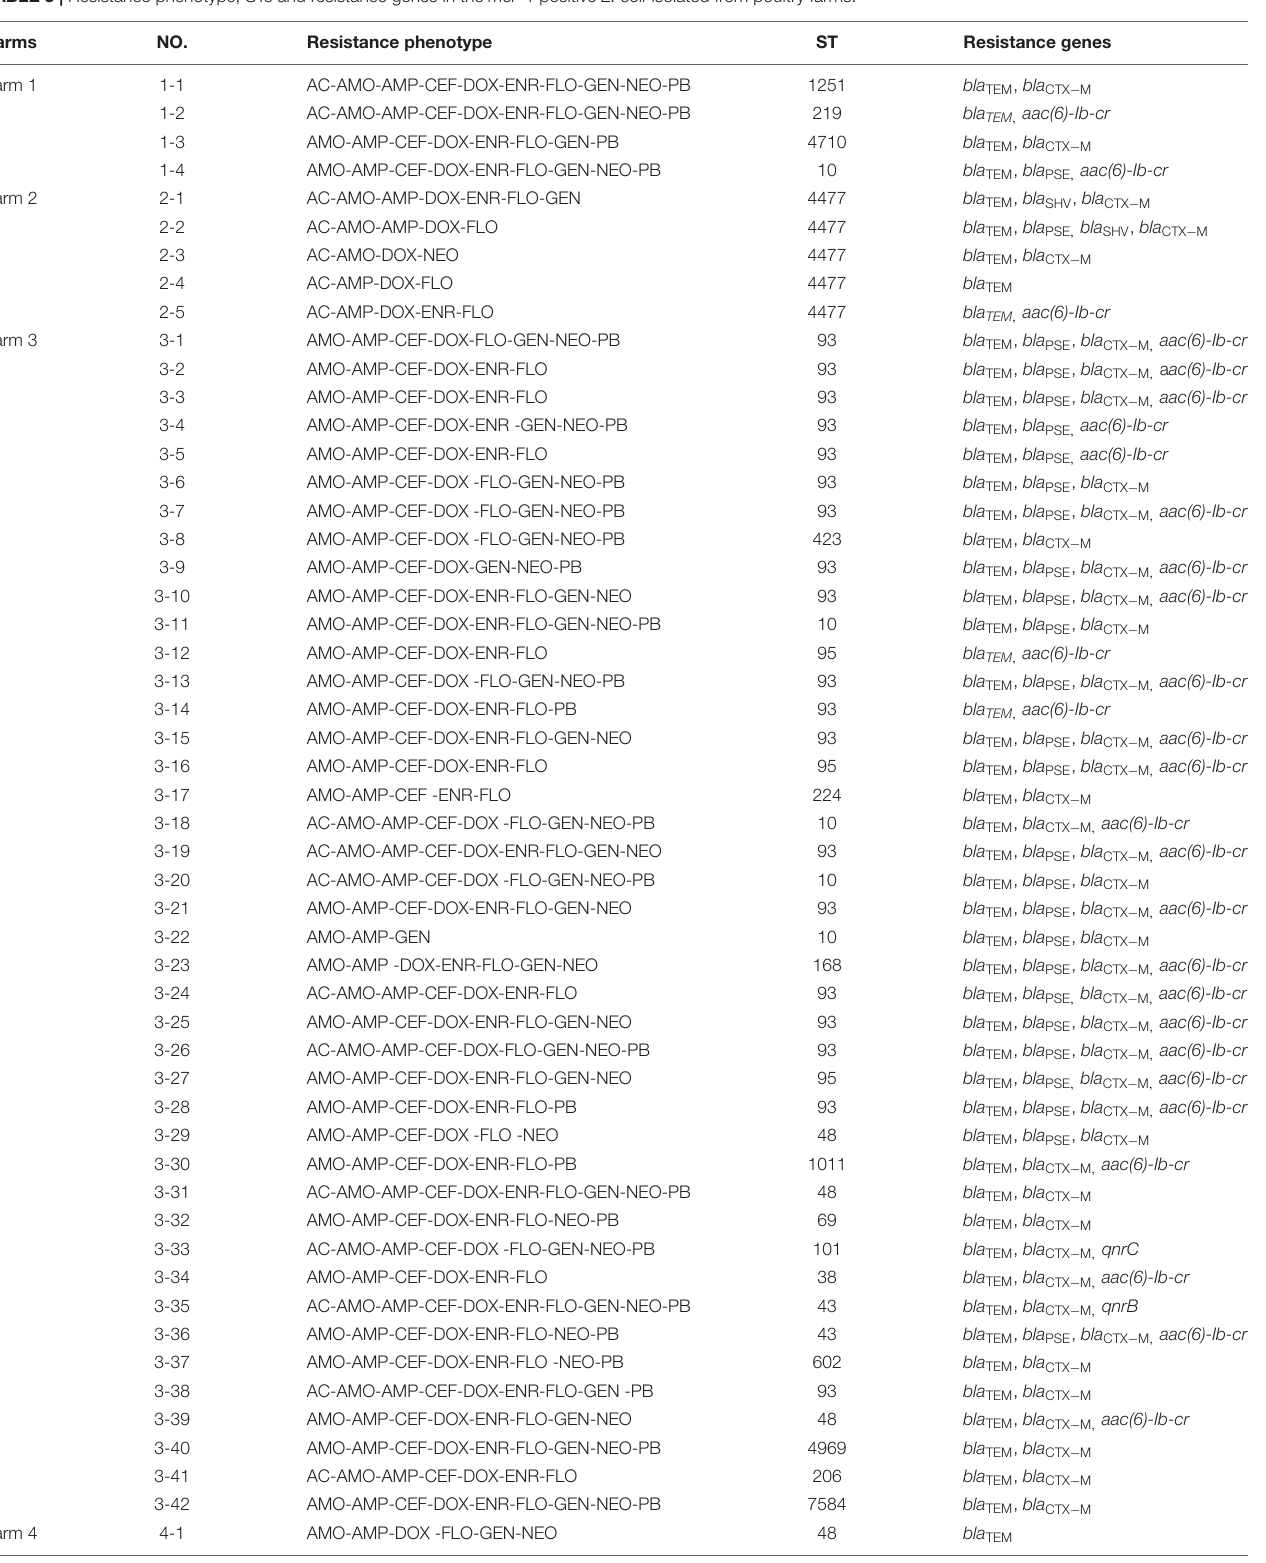
TABLE 3 | Resistance phenotype, STs and resistance genes in the mcr -1 positive E. coli isolated from poultry farms. Farms NO. Resistance phenotype ST Resistance